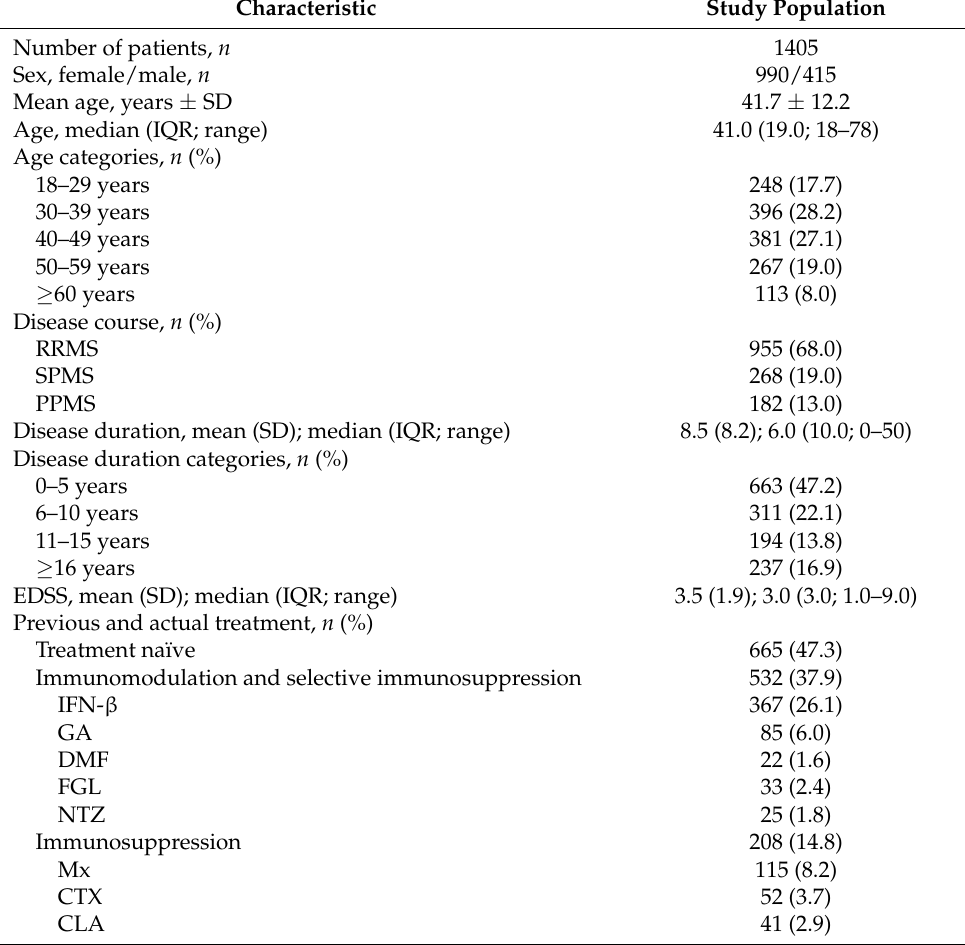
Table 1. Clinical and demographic characteristics of MS patients at the time of the STRATIFY JCV DxSelect